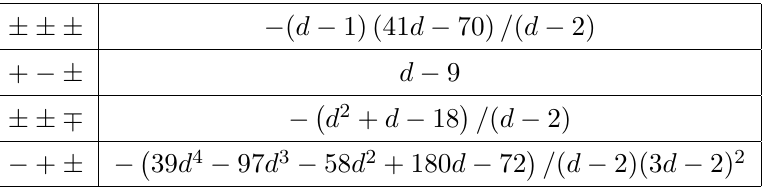
Table 6 . For the corresponding conformal boundary condition in the left column, we report the (cid:0) 2 b ( d − 5) / 2 c Γ 2 ( (cid:1) for the /∂ 3 values of π d c d/ 2) ψ theory in the right DD /